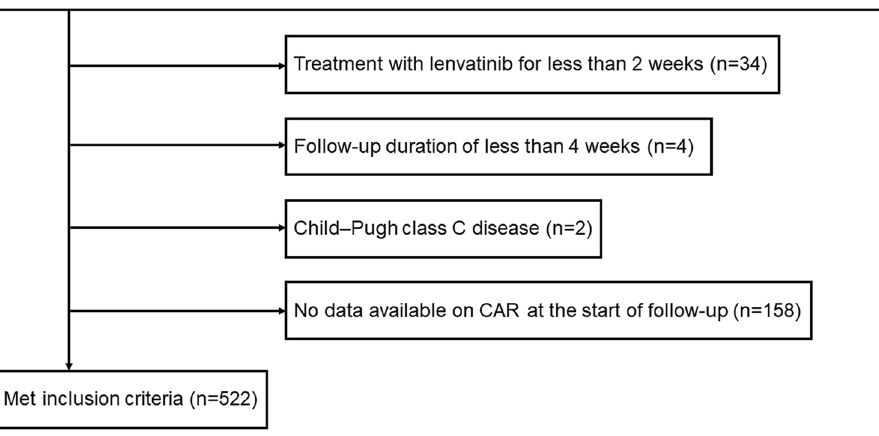
Figure 5. Flowchart of the patient selection process. HCC, hepatocellular carcinoma; CAR, C-reactive protein to albumin